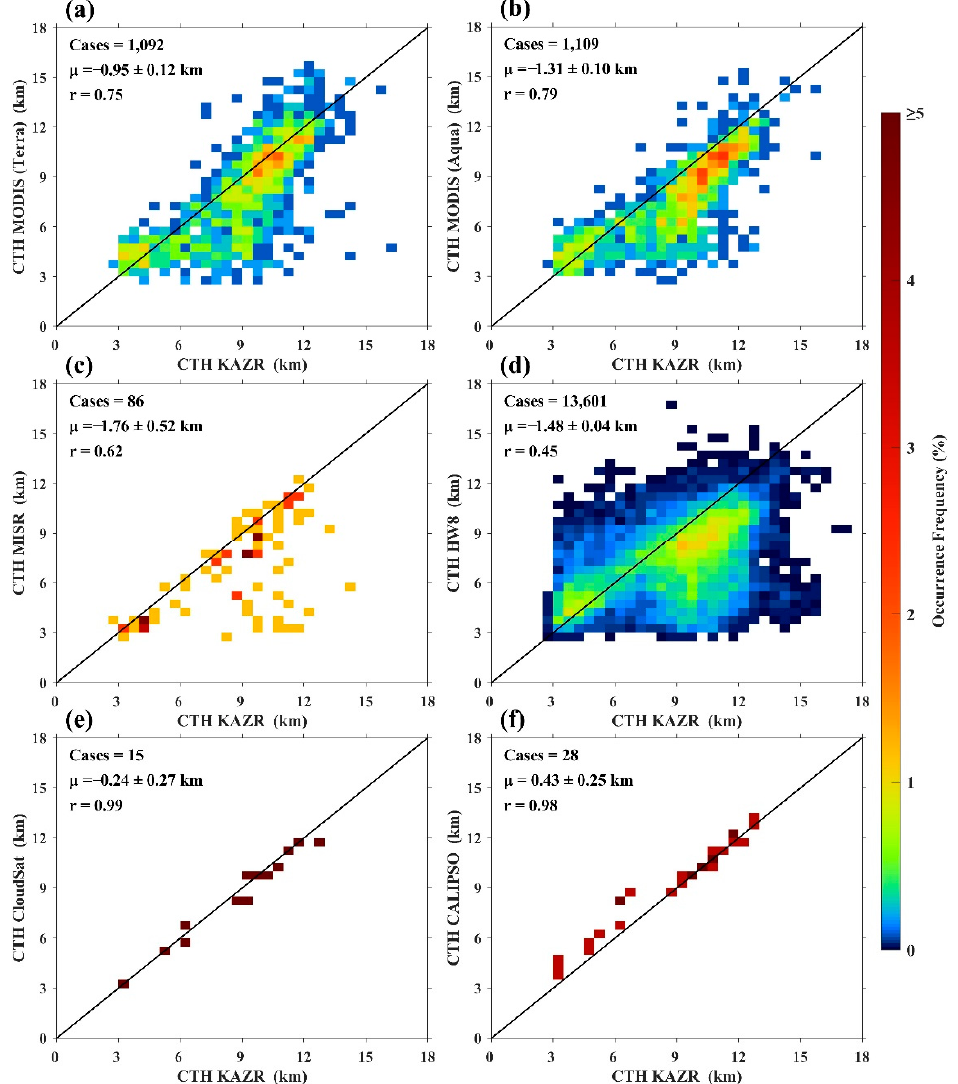
Figure 5. Density scatters of average CTH for non-overlapping clouds. Each colored panel represents the frequency of mean CTH measured by satellites and KAZR over a 500 m interval. The black line represents a standard reference line with a slope of 1. The number of cases, the correlation coefficient (r), and the mean difference provided at the 95% significance level ( μ , satellite CTH minus KAZR CTH) are marked above the subplot. These subplots are for different satellite-KAZR pairs, ( a ) MODIS (Terra), ( b ) MODIS (Aqua), ( c ) MISR, ( d ) HW8, ( e ) CloudSat, and ( f ) CALIPSO.